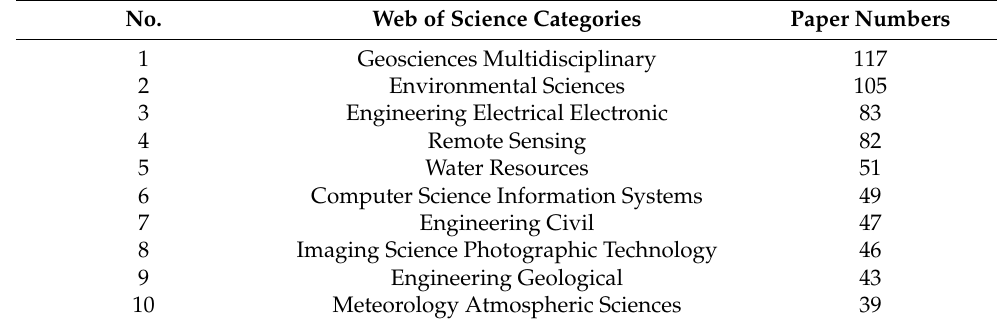
Table 2. The main disciplinary categories of China’s dynamic disaster monitoring and early warning international research